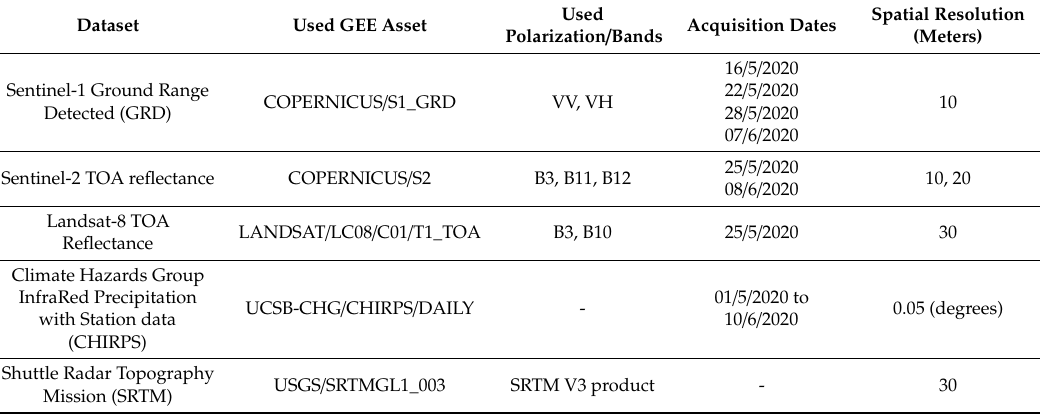
Table 1. Datasets and Google Earth Engine (GEE) assets utilized in this